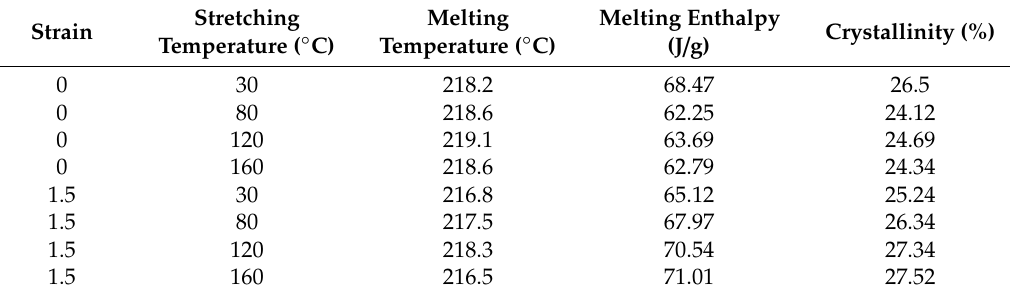
Figure 2. The DSC curves of PA612 films at the strain of ( a ) ε = 0 and ( b ) ε = 1.5. Table 1. The crystallinity for uniaxially stretched PA612 film.